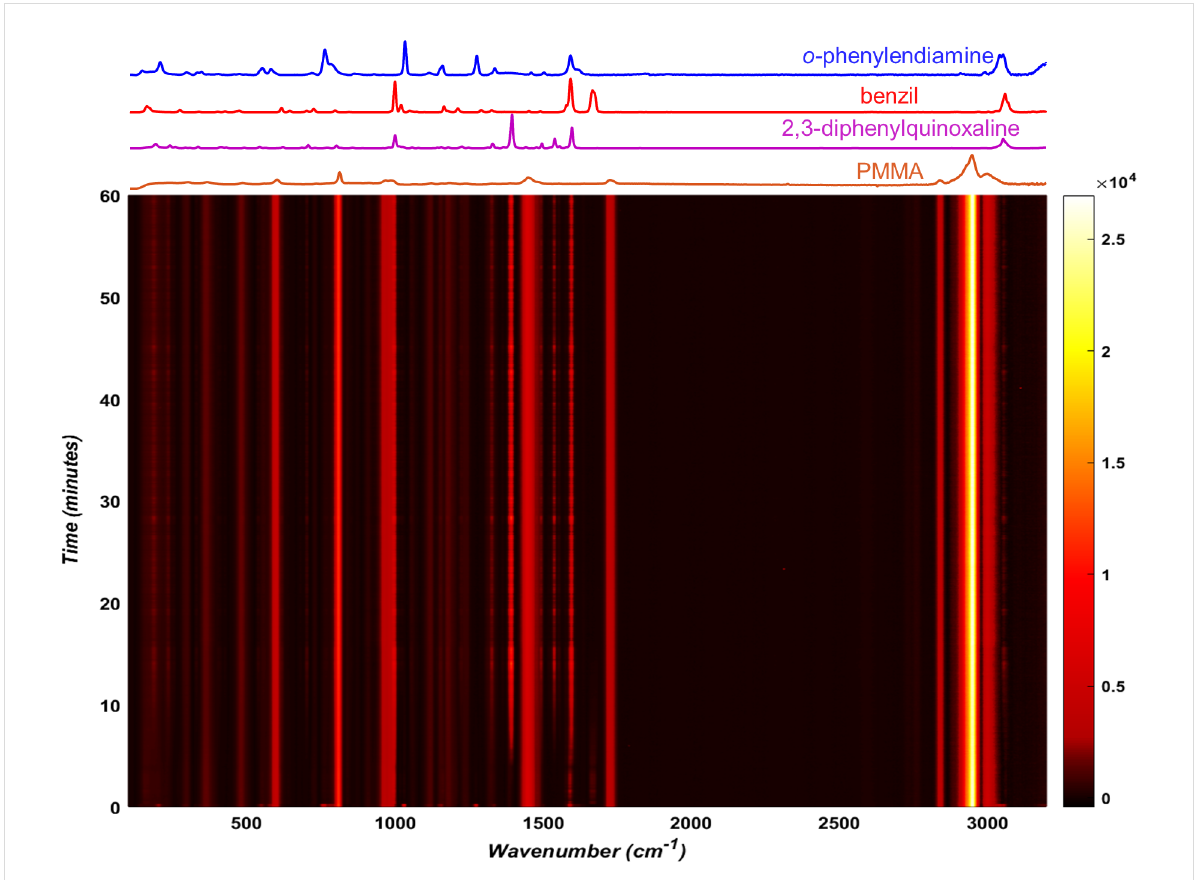
Figure 1: Time-resolved Raman spectrum for the double condensation of o- phenylenediamine and benzil to form 2,3-diphenylquinoxaline by milling at 30 Hz, with relevant spectra of reaction components and the PMMA milling jar shown